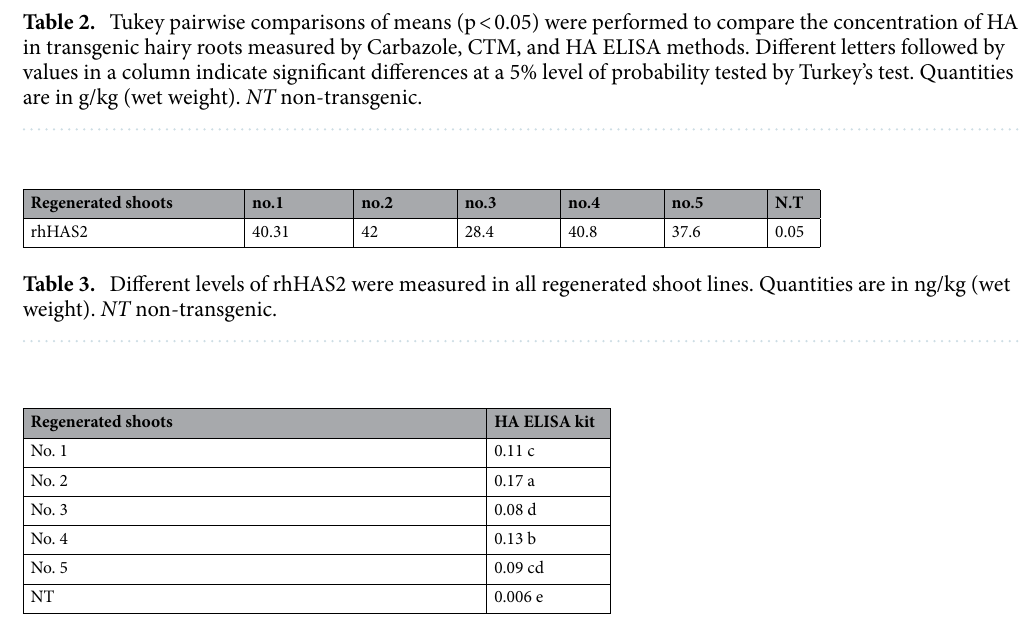
Table 4. Tukey pairwise comparisons of means (p < 0.05) were performed to compare the concentration of HA in regenerated shoot lines measured by the HA ELISA kit. Different letters followed by values in a column indicate significant differences at a 5% level of probability tested by Turkey’s test. Quantities are in g/kg (wet weight). NT